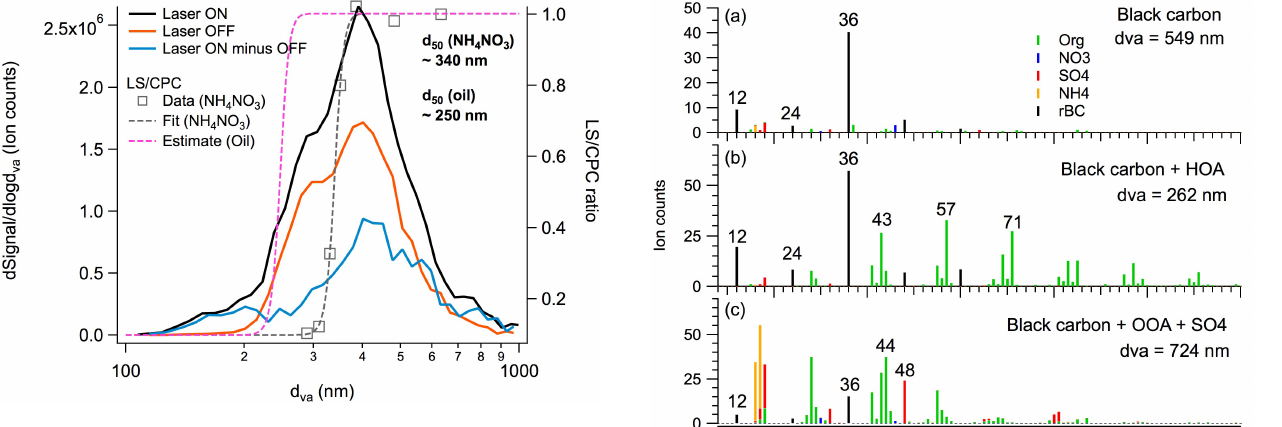
Figure 5. Size distributions of total ion counts from the ambient sin- gle particle measurements (black: laser-on mode, orange: laser-off mode, blue: difference between laser-on and laser-off modes). The grey square (data) and grey dashed line (fitting) represent the count- ing efficiency (the ratio of light scattering counts and condensation particle counter signals (LS/CPC), left axis) of the light scattering module for ammonium nitrate particles. The pink dashed line indi- cates an estimated light scattering cutoff d va for spherical hydrocar- bon oil droplets (i.e., shape factor = 1 and density = 1gcm − 3 ) .